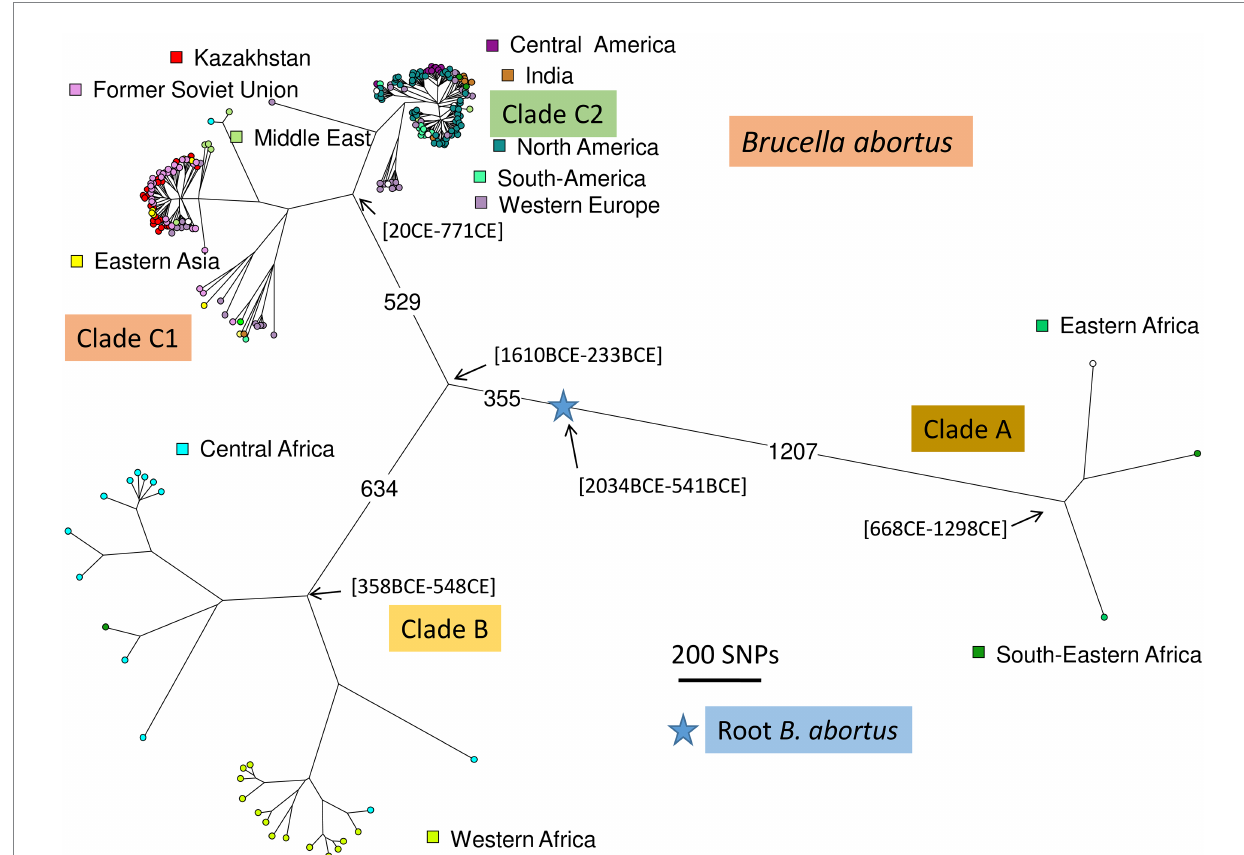
FIGURE 5 Global B. abortus phylogeny. Maximum parsimony tree based on core genome SNPs. A total of 236 representative strains was used and 16,987 SNPs were called by mapping on genome accession GCA_000740155 ( B. abortus strain Tulya). The size of the resulting tree is 17,178 SNPs (homoplasia 1.12%). Nodes are colored according to geographic origin as indicated. The blue star indicates the root of the phylogeny (branching point toward the B. melitensis type strain 16 M). The largest branch lengths and the scale are shown. Representative estimated divergence dates are indicated (CE, common era; BCE, before common